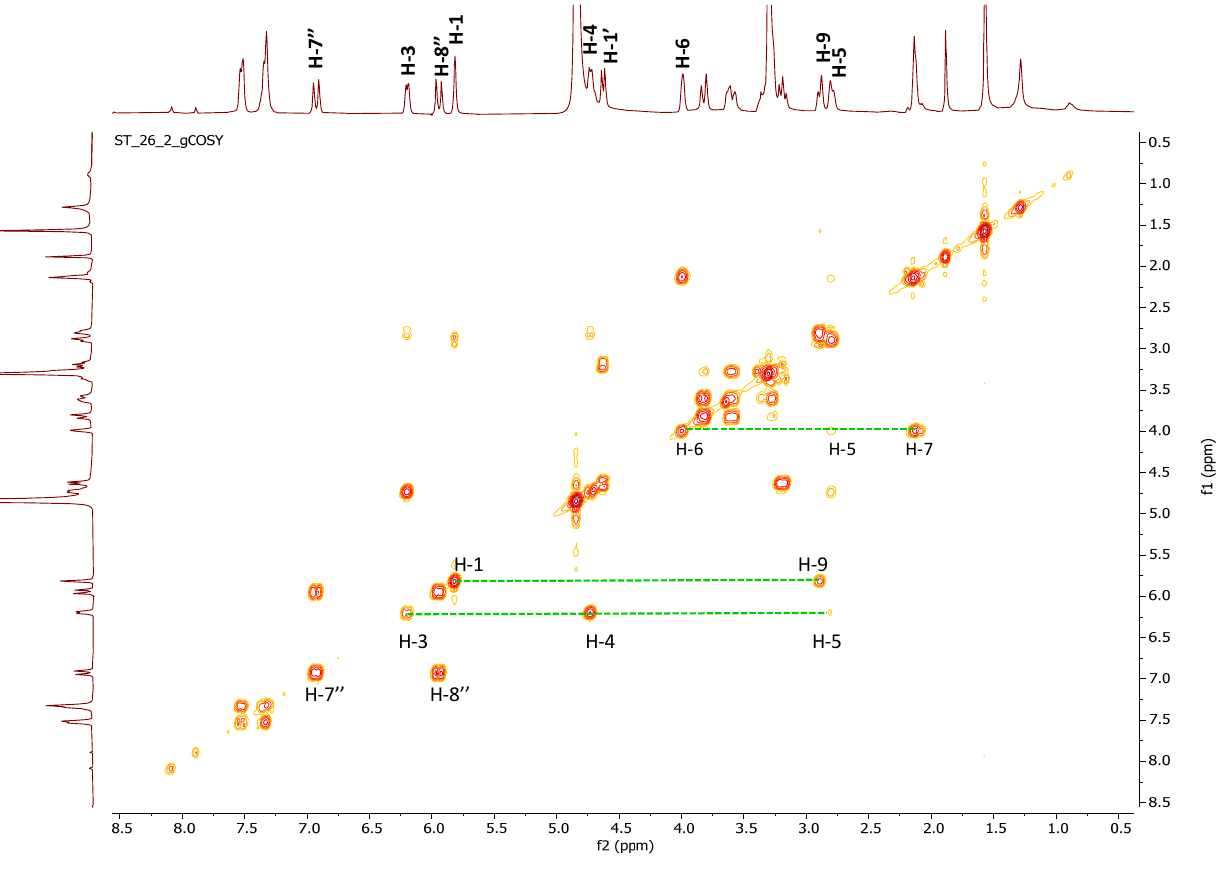
Figure 6. COSY and 1 H ‐ NMR spectra of compound 13 .